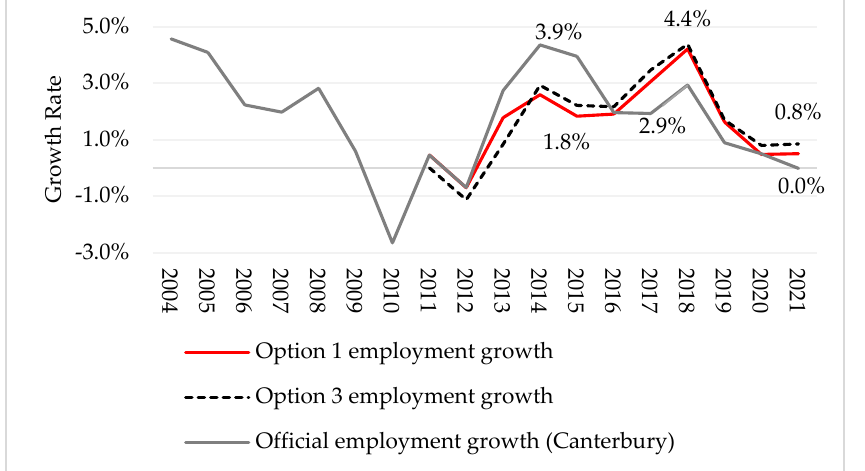
Figure 6. Canterbury employment growth, 2004–2021. Source : (StatsNZ 2021b) and author’s calculations.